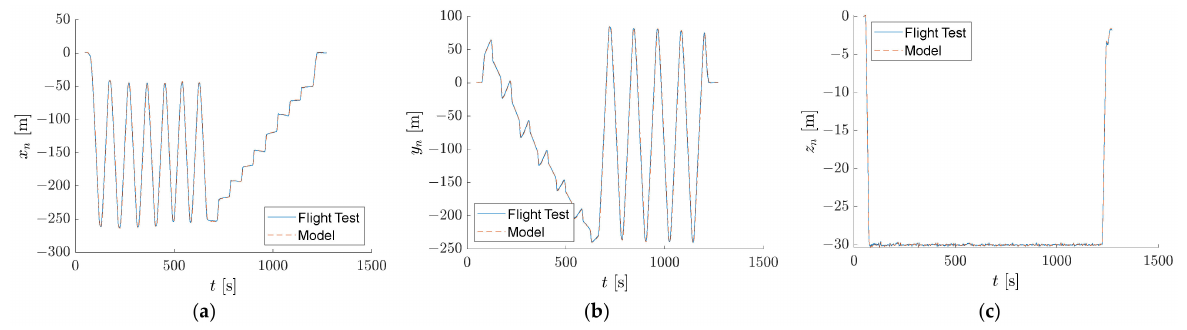
Figure 19. Quadrotor position: ( a ) north–south, ( b ) west–east, and ( c ) altitude.